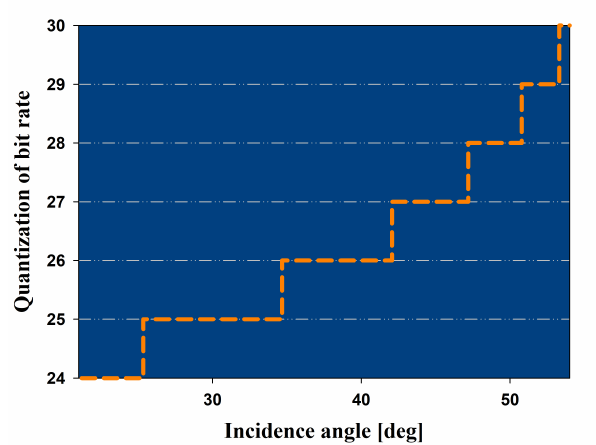
Figure 6. The variation in the quantization bit rate N bit with the incidence angle φ .